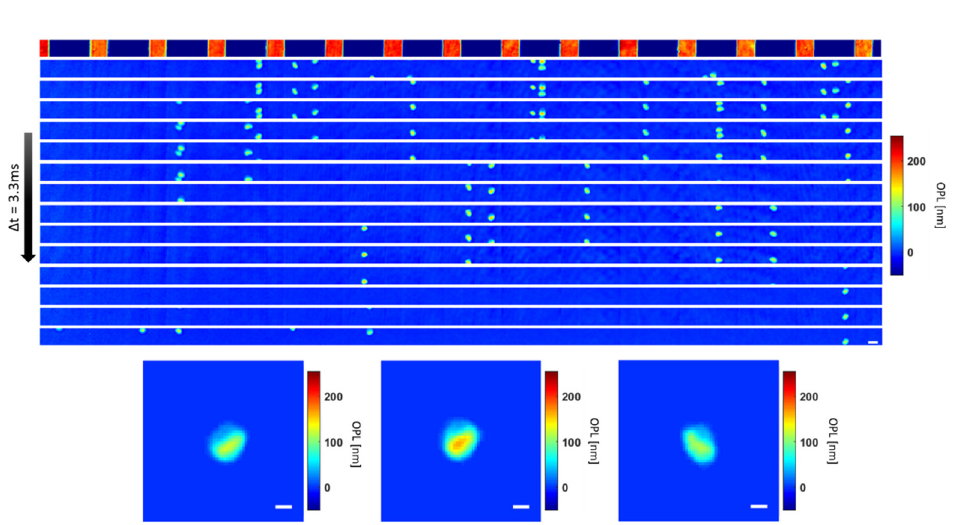
Figure 3. Top: Flow sequence with channels shown at the top subtracted as a background. Scale bar = 10 µm. Bottom: Selected red blood cells from the flow sequence on top. Scale bar = 5 µm (Supplementary Materials: Video S1).